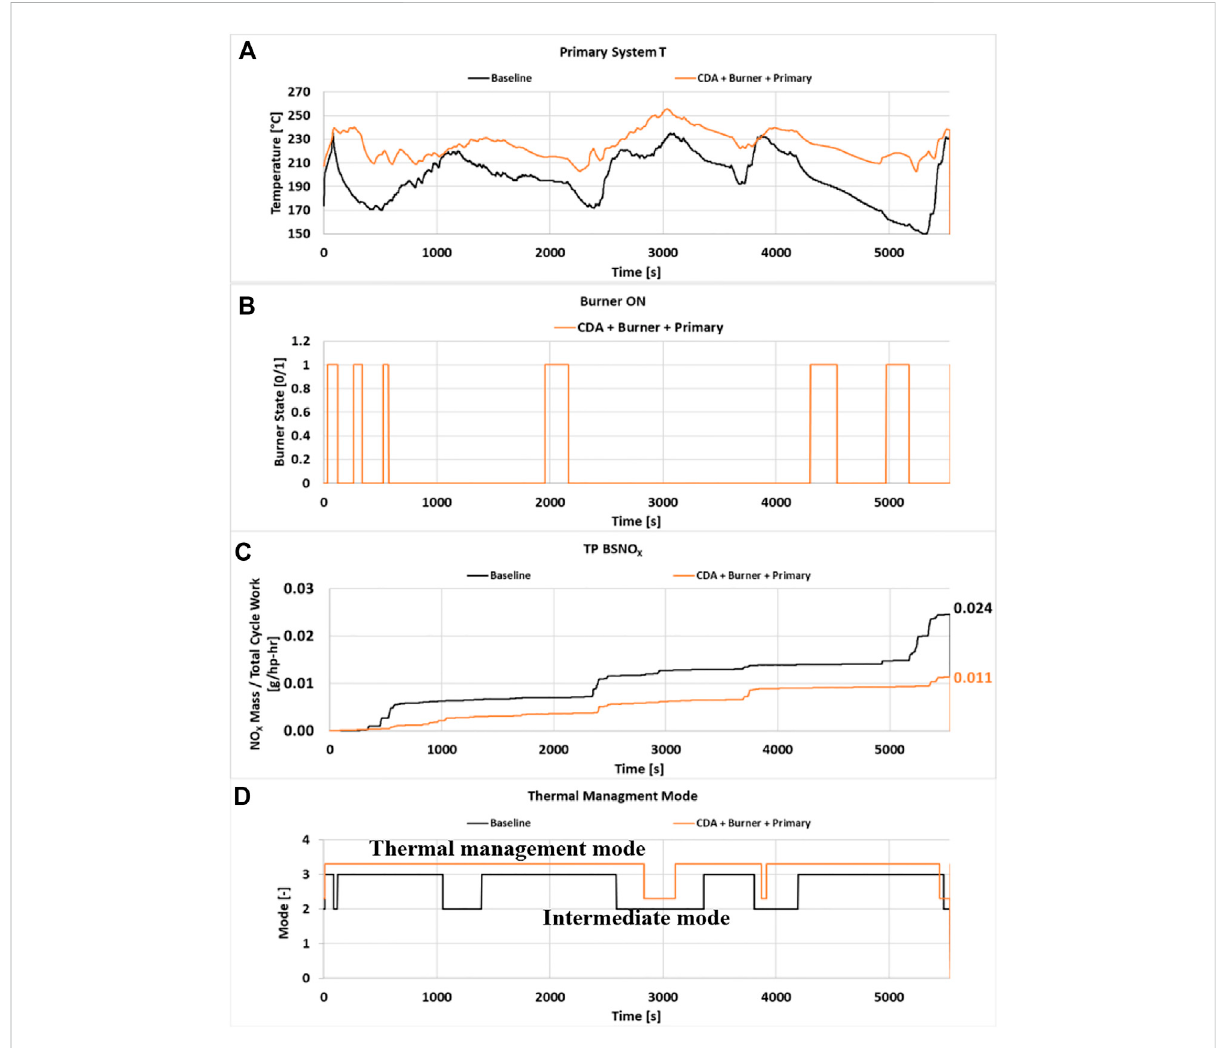
FIGURE 11 LLC measurement comparison between Baseline and CDA + Burner + Primary systems. (A) Primary system temperature, (B) Burner state, (C) Cumulative TP BSNO X , (D) Engine mode comparison.